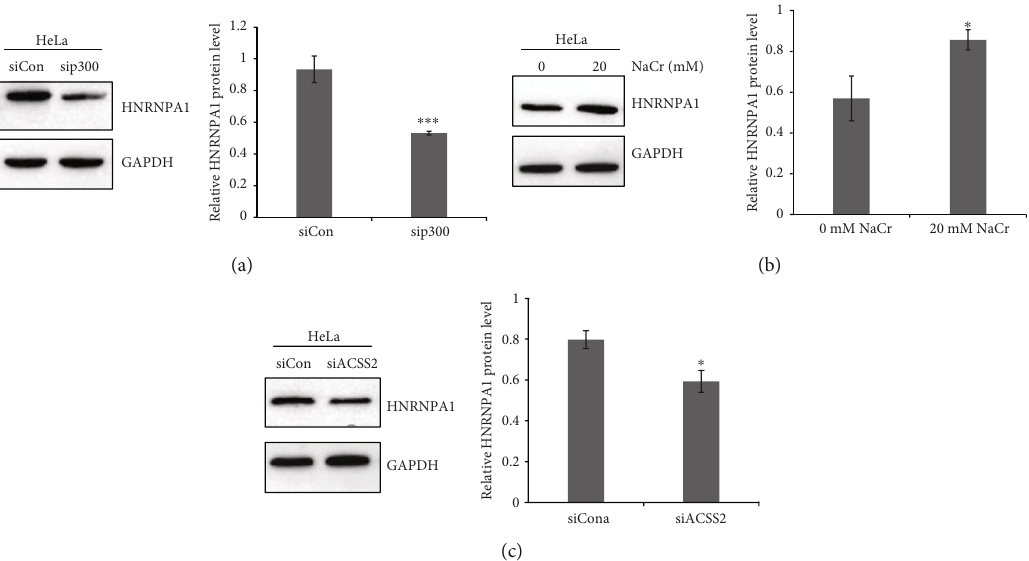
Figure 3: p300-mediated lysine crotonylation is responsible for HNRNPA1 expression in HeLa cells. (a) HNRNPA1 expression was measured by western blot in HeLa cells stably expressing nontargeting control (siCon) and sip300. The relative intensities of HNRNPA1/GAPDH were quanti fi ed using ImageJ. ∗∗∗ P < 0 : 001 . (b) HNRNPA1 expression was measured by western blot in NaCr-treated HeLa cells. The relative intensities of HNRNPA1/GAPDH were quanti fi ed using ImageJ. ∗ P < 0 : 05 . (c) HNRNPA1 expression was measured by western blot in HeLa cells stably expressing nontargeting control (siCon) and siACSS2. The relative intensities of HNRNPA1/GAPDH were quanti fi ed using ImageJ. ∗ P < 0 : 05 .